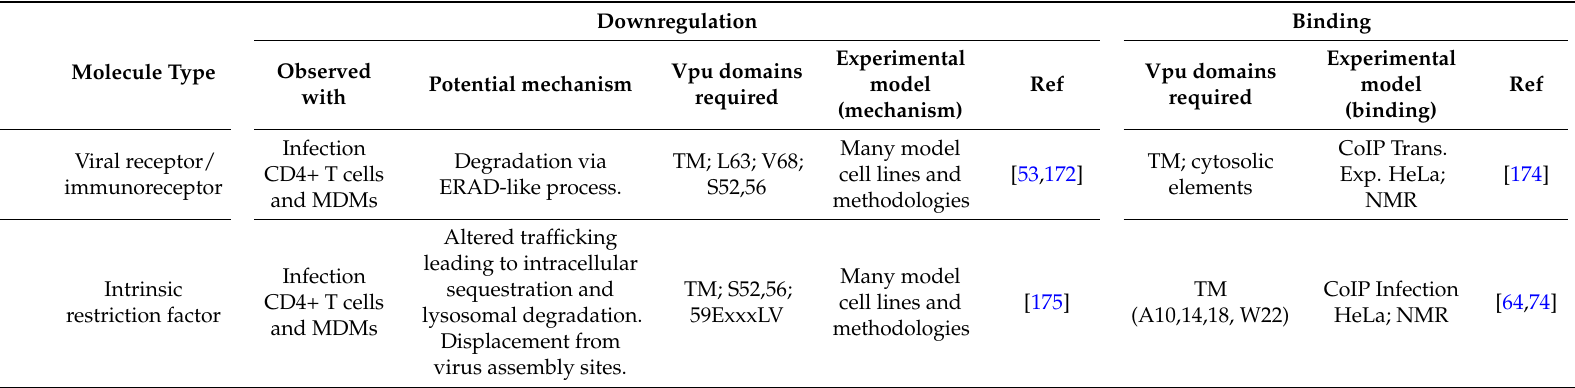
Table 2. Host PM proteins targeted by HIV-1